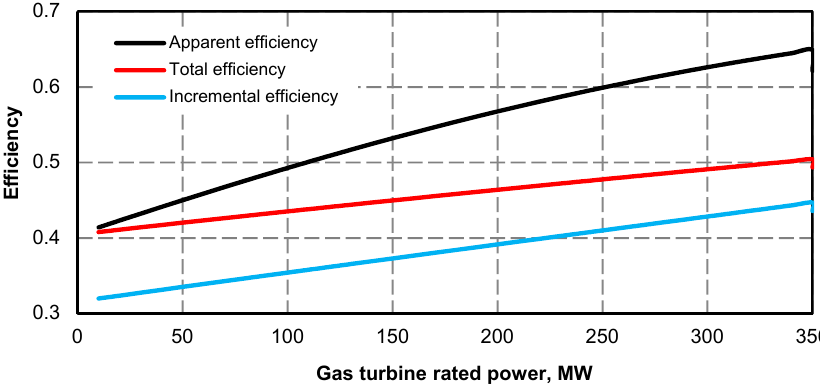
Figure 21. The energy e ffi ciency for the power unit with superstructure added as a function of gas Figure 21. The energy efficiency for the power unit with superstructure added as a function of gas Figure 21. The energy efficiency for the power unit with superstructure added as a function of gas Figure 21. The energy efficiency for the power unit with superstructure added as a function of gas turbine rated power for a maximum fixed stream of 319.4 kg / s fresh steam fed to the steam turbine. turbine rated power for a maximum fixed stream of 319.4 kg/s fresh steam fed to the steam turbine. turbine rated power for a maximum fixed stream of 319.4 kg/s fresh steam fed to the steam turbine. turbine rated power for a maximum fixed stream of 319.4 kg/s fresh steam fed to the steam turbine.